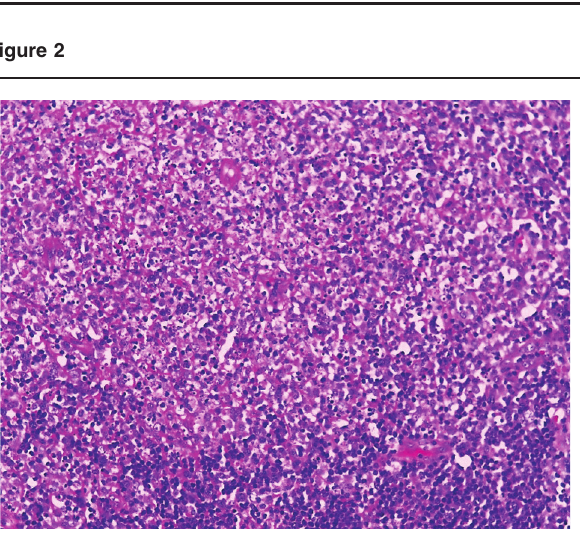
Chest radiograph showing no obvious